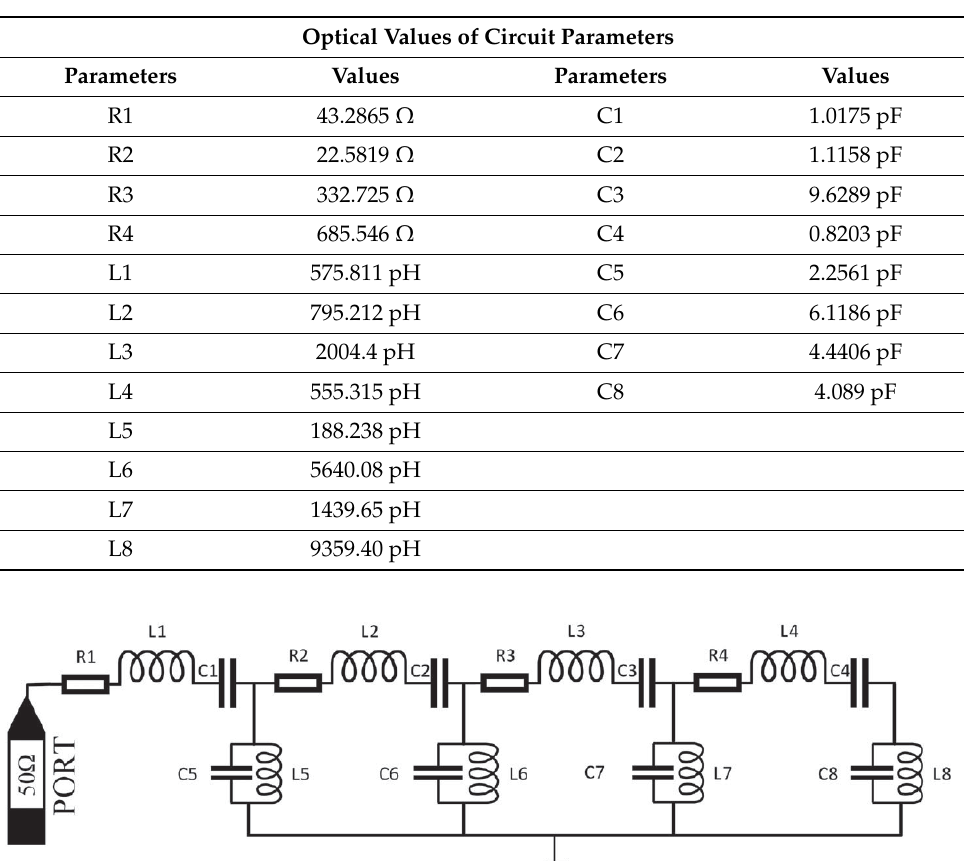
Table 1. The values of equivalent circuit parameters.